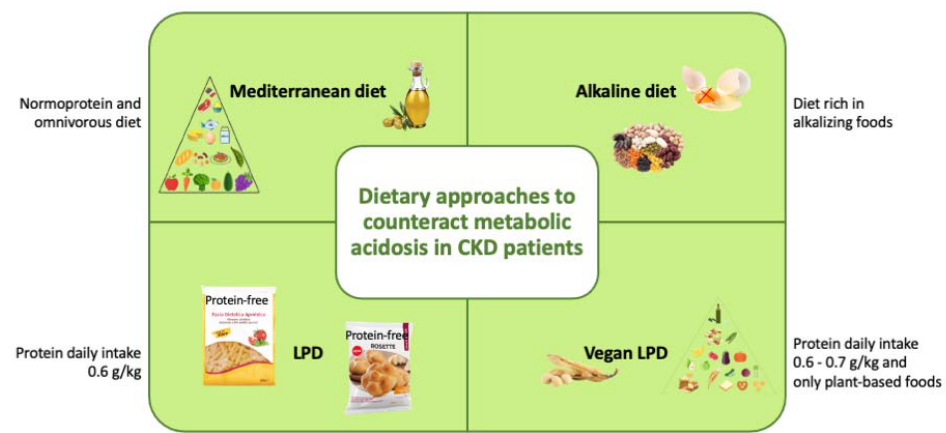
Figure 2. Dietary approaches to counteract metabolic acidosis in CKD patients. Abbreviations: b.w, body weigh; LPD, low-protein diet.